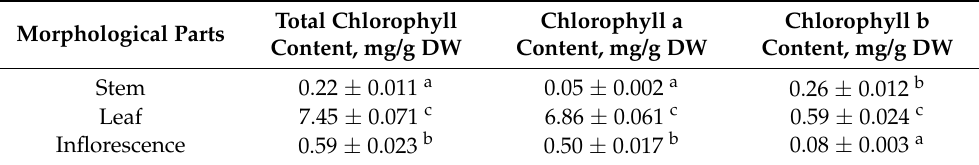
Table 2. The amount of chlorophyll contents of A. cordata morphological parts cited. Morphological Parts